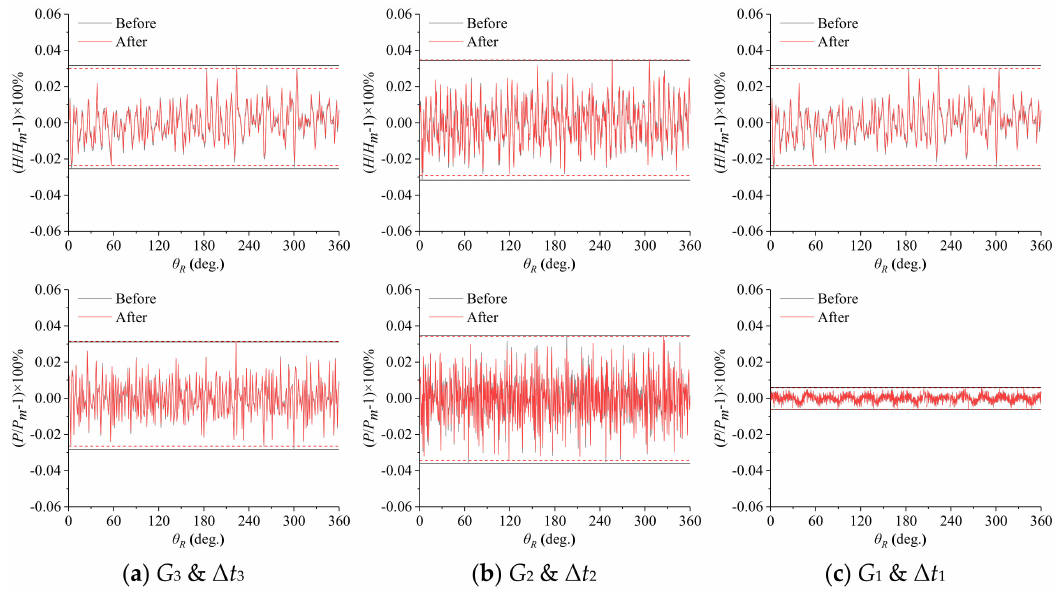
Figure 10. Comparison of the unsteady head H ( top row ) and power P ( bottom row ) before (black lines) and after (red lines) removing the components arising from stator/rotor interaction. The abscissa, θ R , denotes the angular position of a rotor blade. The head and power are expressed respectively in percents relative to H m and P m , the averages over a complete revolution. Q = 0.42 m 3